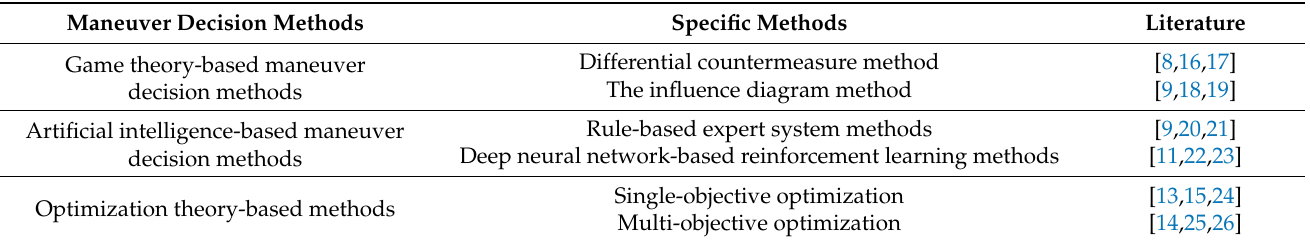
Table 1. Overview of close air combat maneuver decision